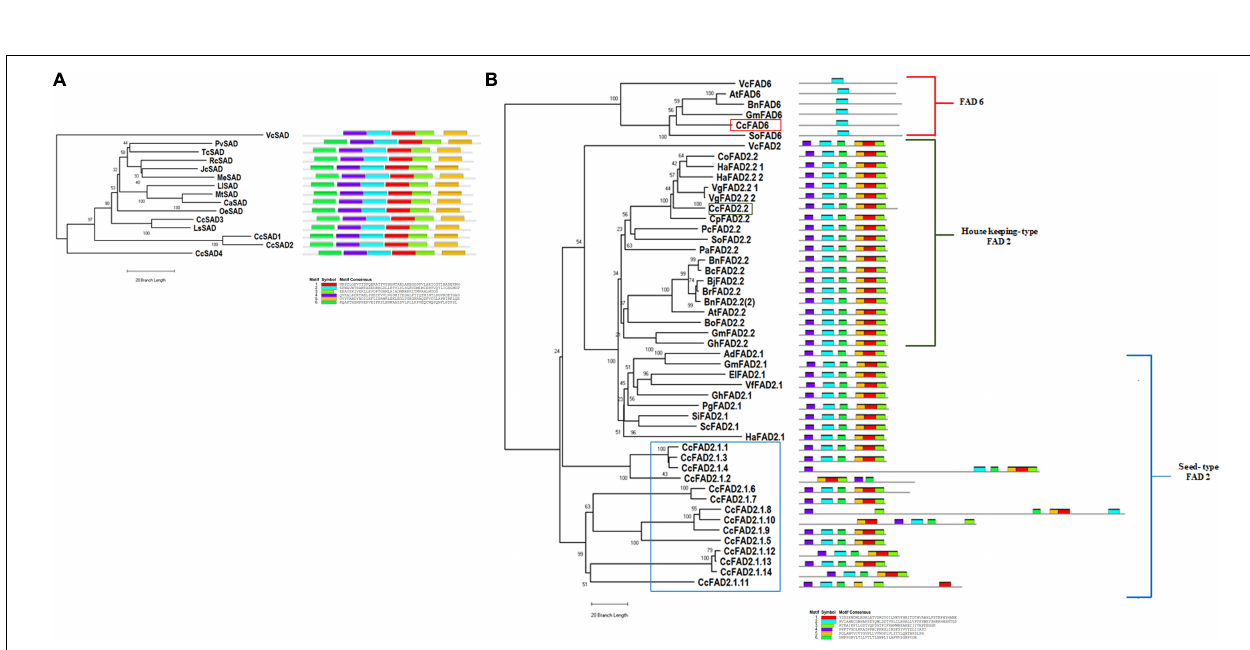
FIGURE 2 | Phylogenetic tree (on the left) and motif composition (on the right) of SAD and FAD candidate genes from Cynara cardunculus and other 31 representative species (Species and Accession numbers are reported in Supplementary Table 2 ). The amino acid sequences of all the selected proteins were aligned using the ClustalW program and subjected to phylogenetic analysis by the neighbor-joining method using the MEGAX software. Motif composition of the Cc FAD and Cc SAD proteins was obtained by the MEME program. The gray line represents the length of the proteins, and the rectangles in different colors represent the different motifs from 1 to 6. (A) Phylogenetic tree and motif composition of C. cardunculus SADs plus other 10 plant species. Rooted phylogram was obtained by using the Volvox carteri Vc SAD sequence as the outgroup. (B) Phylogenetic tree and motif composition of C. cardunculus FADs plus other 21 plant species. The house-keeping Cc FAD2.2 protein is indicated by a green box, the seed-type Cc FAD2.1 proteins are indicated by a blue box, and the Cc FAD6 protein is indicated by a red box. Rooted phylogram was obtained by using the Volvox carteri Vc FAD2 and Vc FAD6 sequences as the outgroups for FAD2 and FAD6 analysis, respectively.